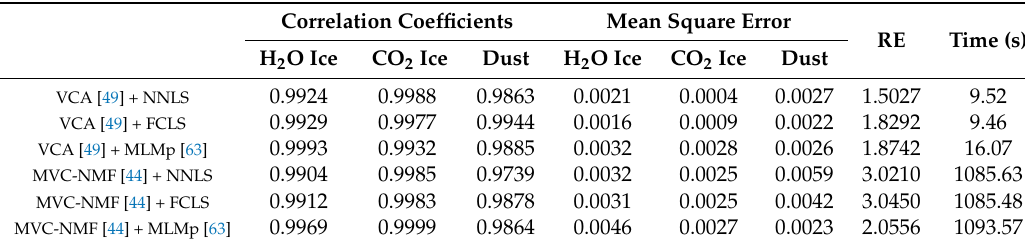
Table 8. Correlation coefficients and the mean square error between the real abundances of H 2 O ice, CO 2 ice and dust, reconstruction error (RE) and the time cost of each method and the abundances of the endmembers extracted by VCA and